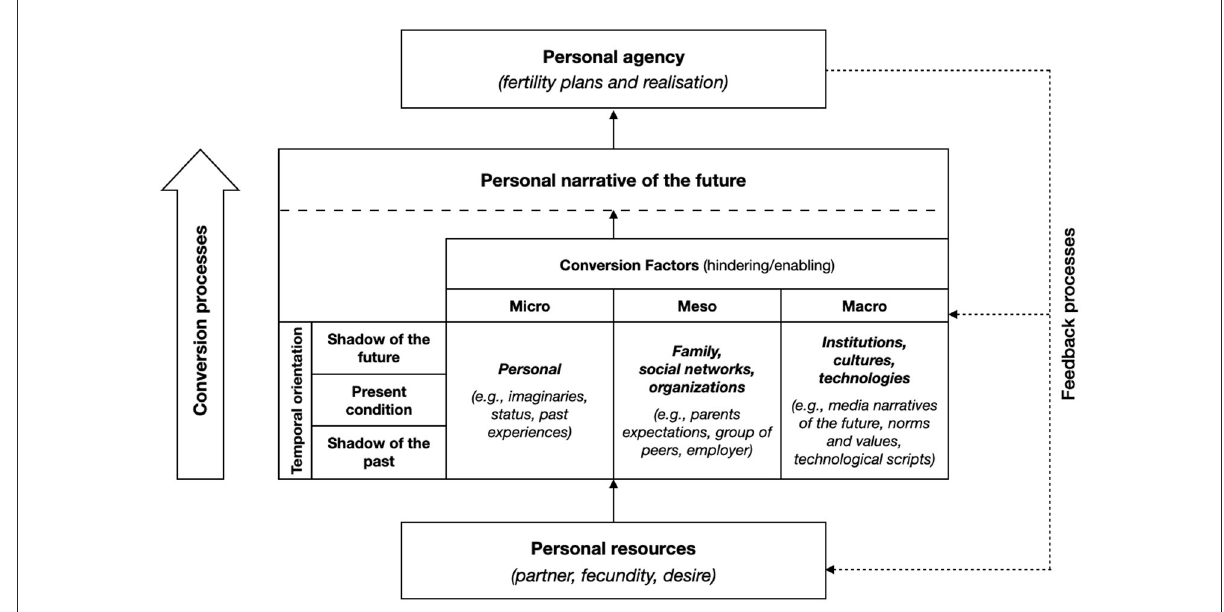
FIGURE1 Fertility conversion processes (adapted from Bazzani,